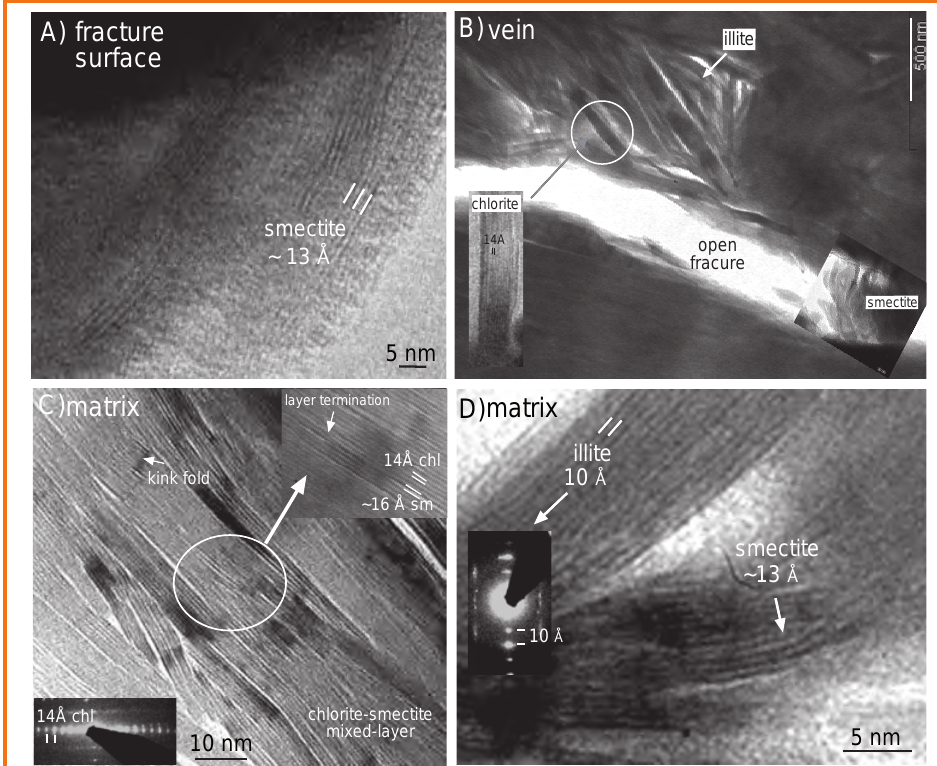
Figure 2. Low and high resolution TEM images of [A] smectite ultrasonically separated from fracture surfaces, [B] smectitic vein fillings that are surrounded by packets of chlorite and illite crystals, [C] rock-matrix samples with interstratifications of chlorite and smectite (note microstructures such as kink folds and layer terminations), and [D] packets of illite growth with illite-smectite mixed-layering and